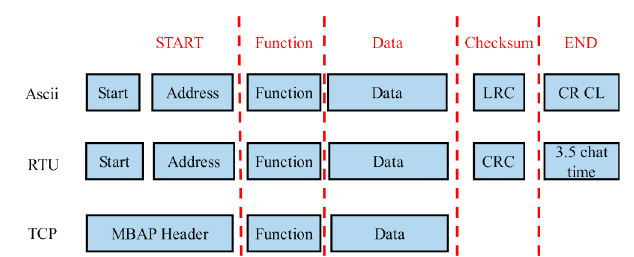
Figure 4. Modbus format.